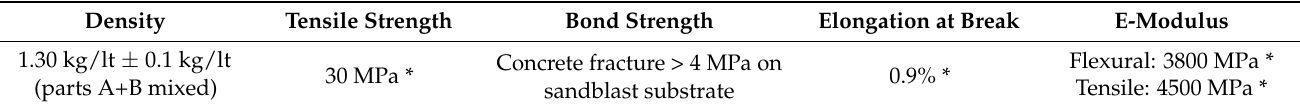
Table 3. Epoxy adhesive properties by Sika